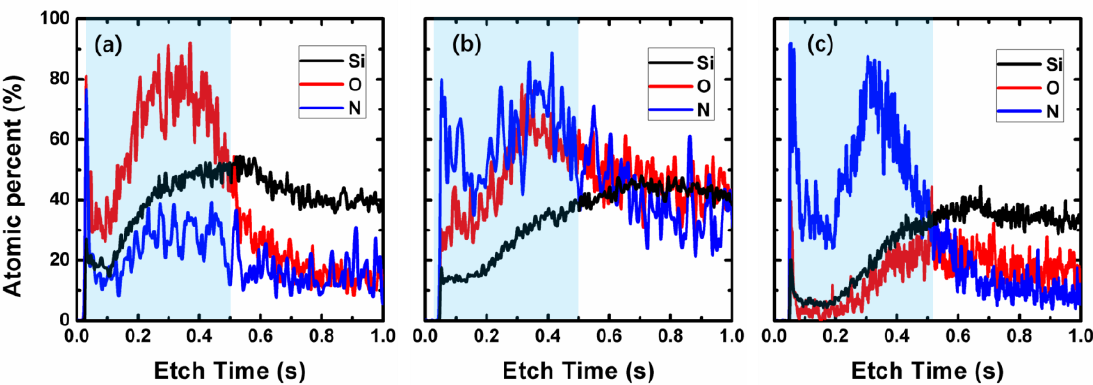
Figure 4. Glow discharge optical emission spectroscopy (GDOES) depth profile of Si, O, and N element in ( a ) SiON-1, ( b ) SiON-2, and ( c ) SiON-3 film.